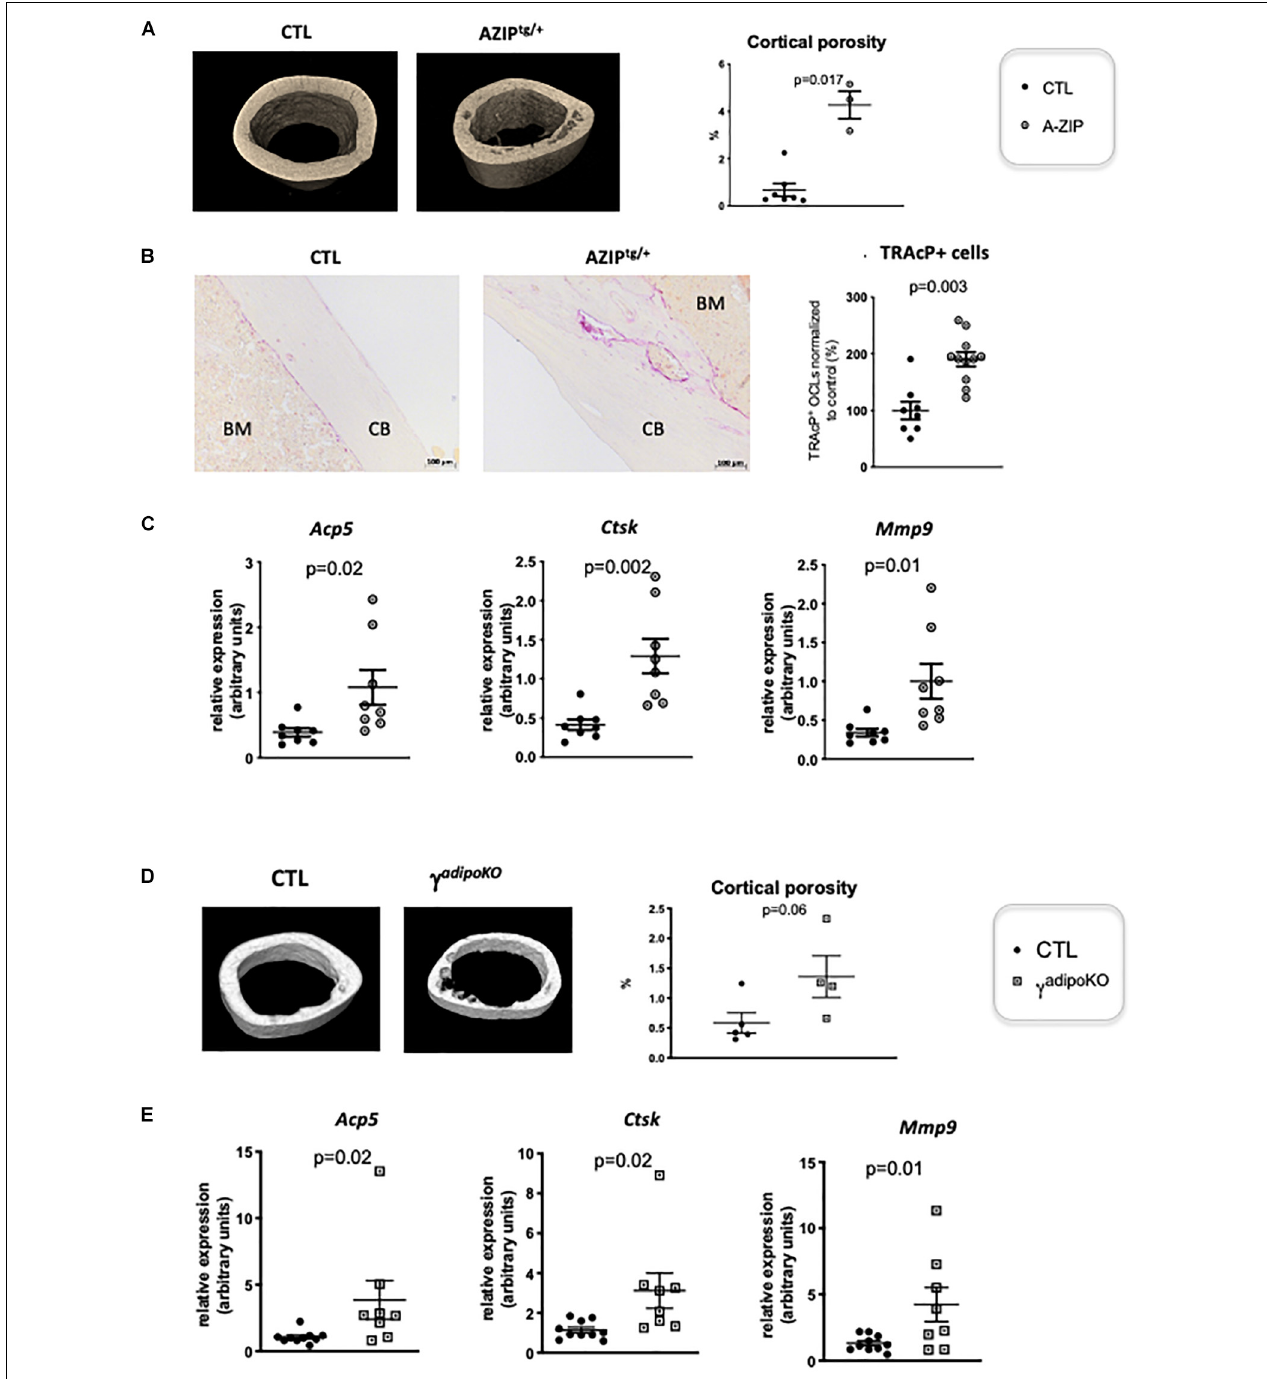
FIGURE 2 | Lipoatrophy is responsible for unregulated osteoclastogenesis. (A) Representative 3D sections of midshaft femur from 1 year-old female A-ZIP tg / + and CTL littermates (left panels) and femoral cortical porosity measured by micro-CT analysis of femur from A-ZIP tg / + and control (CTL) littermates (right panel). (B) Representative images of TRAcP staining of longitudinal sections of decalcified femurs, at mid-shaft levels, from control (CTL) or A-ZIP tg / + mice (left panels; CB, cortical bone; BM, bone marrow). The right panel is a quantification of TRAcP positive osteoclasts. (C) RT-qPCR analysis of Acid Phosphatase 5-Tartrate Resistant ( Acp5 ) Cathepsin K ( Ctsk ) and Matrix Metallopeptidase 9 ( Mmp9) expression in femur from A-ZIP tg / + mice and their control littermates. (D) Representative 3D sections of midshaft femur from 1 year-old females PPAR γ adipoKO and CTL littermates (left panels) and femoral cortical porosity measured by micro-CT analysis of femur from PPAR γ adipoKO and control (CTL) littermates (right panel). (E) RT-qPCR analysis of Acid Phosphatase 5-Tartrate Resistant ( Acp5 ) Cathepsin K ( Ctsk ) and Matrix Metallopeptidase 9 ( Mmp9) expression in femur from PPAR γ adipoKO mice and their control littermates. Each dot represents an individual animal. Statistical significance was determined by two-tailed unpaired t